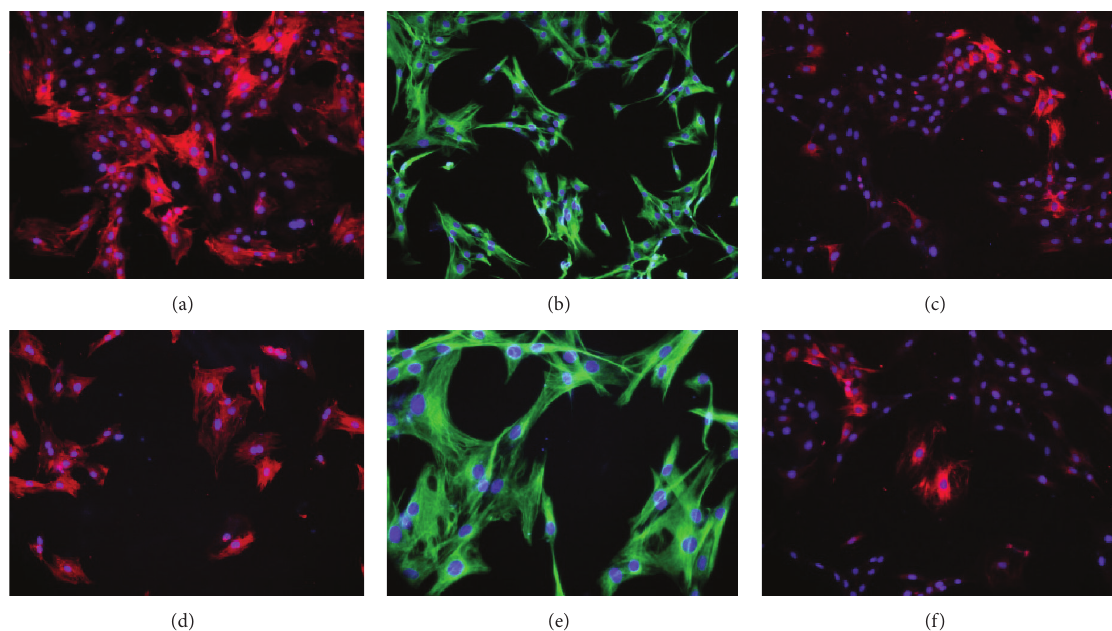
Figure 2: Stellate shape-like cell expression of (a) 𝛼 -SMA, (b) vimentin, and (c) desmin and PSC expression of (d) 𝛼 -SMA, (e) vimentin, and (f) desmin. Representative images for 𝛼 -SMA and desmin staining were red, and those for vimentin were green at 100x magnification.